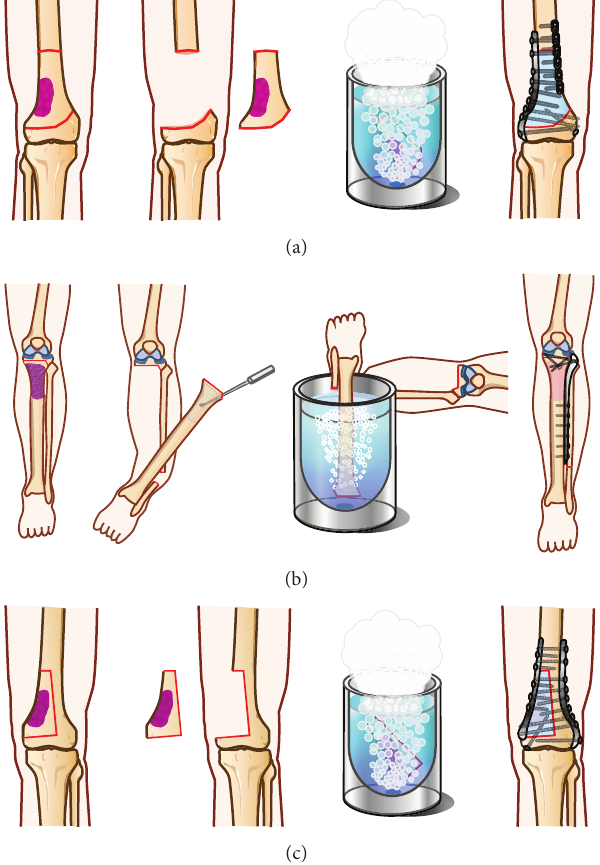
Figure 1: Illustration showing different methods and technique of freezing. (a) Free freezing (intercalary) in distal femur. There